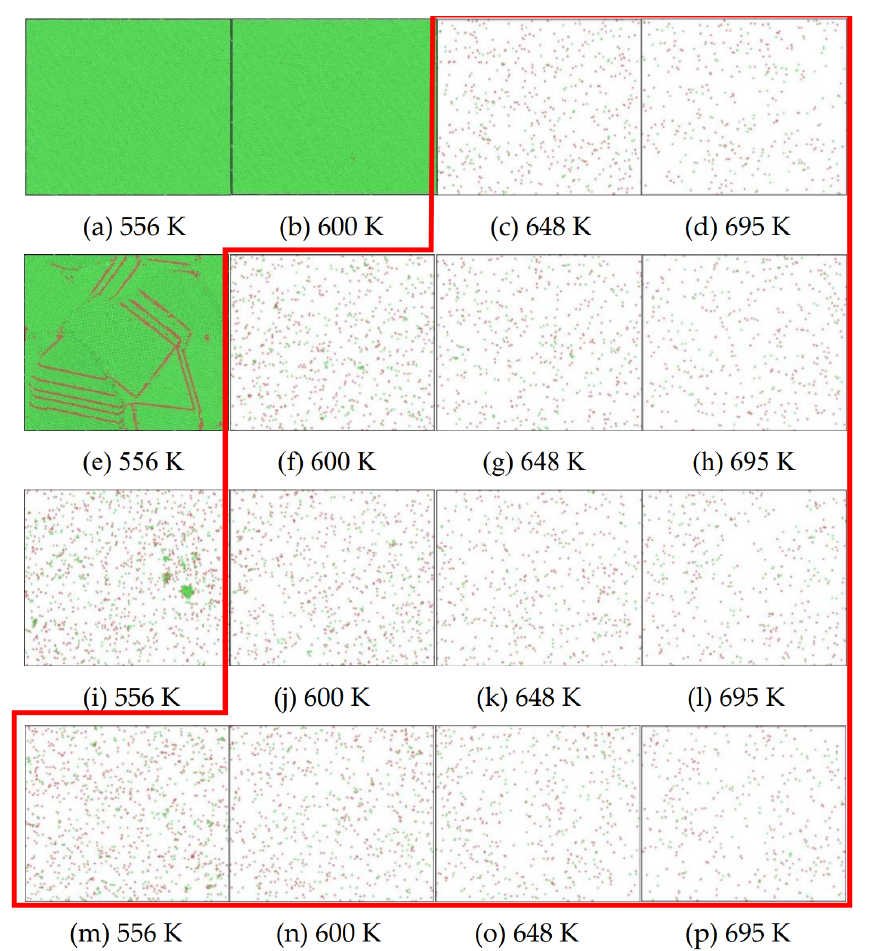
Figure 2. Three-dimensional structure snapshot of Al melt after rapid cooling to different temperatures at different cooling rates. ( a – d ) 2.0 × 10 10 K/s, ( e – h ) 2.0 × 10 11 K/s, ( i – l ) 2.0 × 10 12 K/s, ( m – p ) 2.0 × 10 13 K/s.